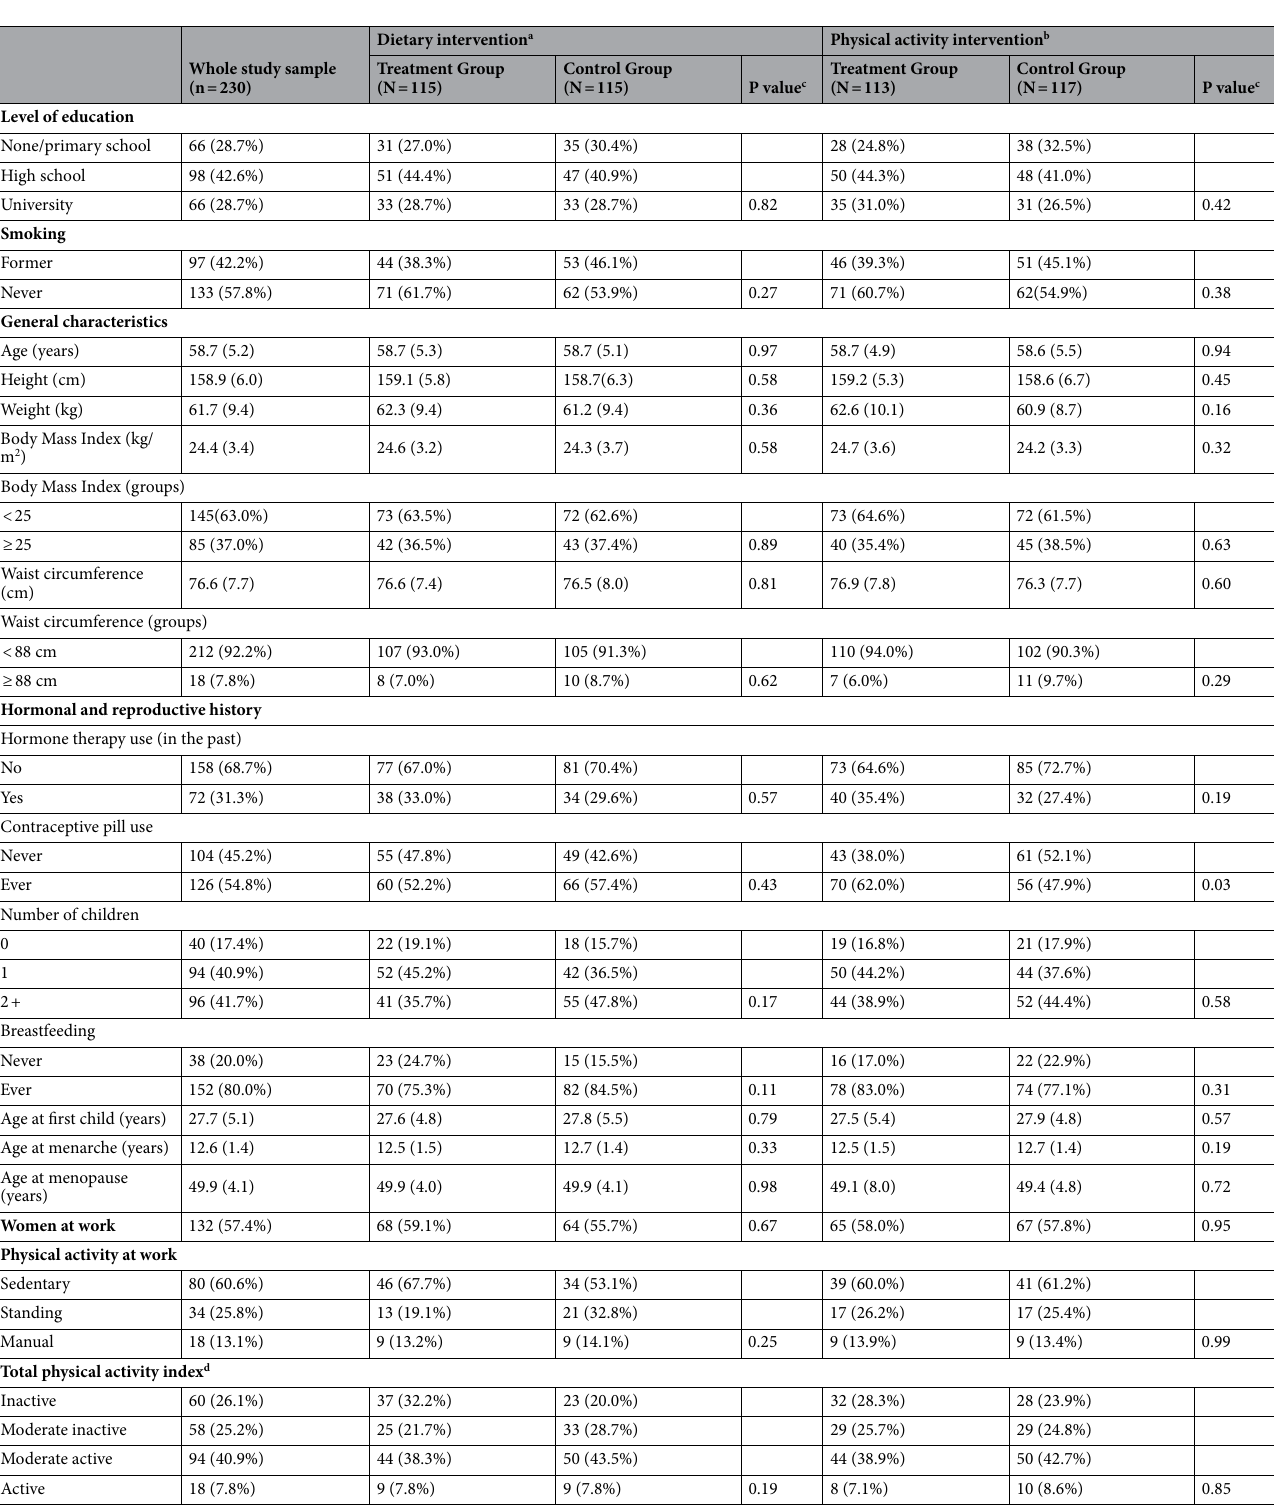
Table 1. Baseline distribution (categorical variables) or mean and standard deviation (continuous variables) of selected characteristics of women enrolled into the DAMA (Diet, Exercise and Mammography) trial, overall and by treatment. a Arms 1 + 3 versus arms 2 + 4. b Arms 2 + 3 versus arms1 + 4. c P values were calculated from GLM for continuous variables and from X 2 test for categorical variables. d The total physical activity index is categorized into four levels based on a cross-tabulation of occupational activity by the combined household and recreational activities in